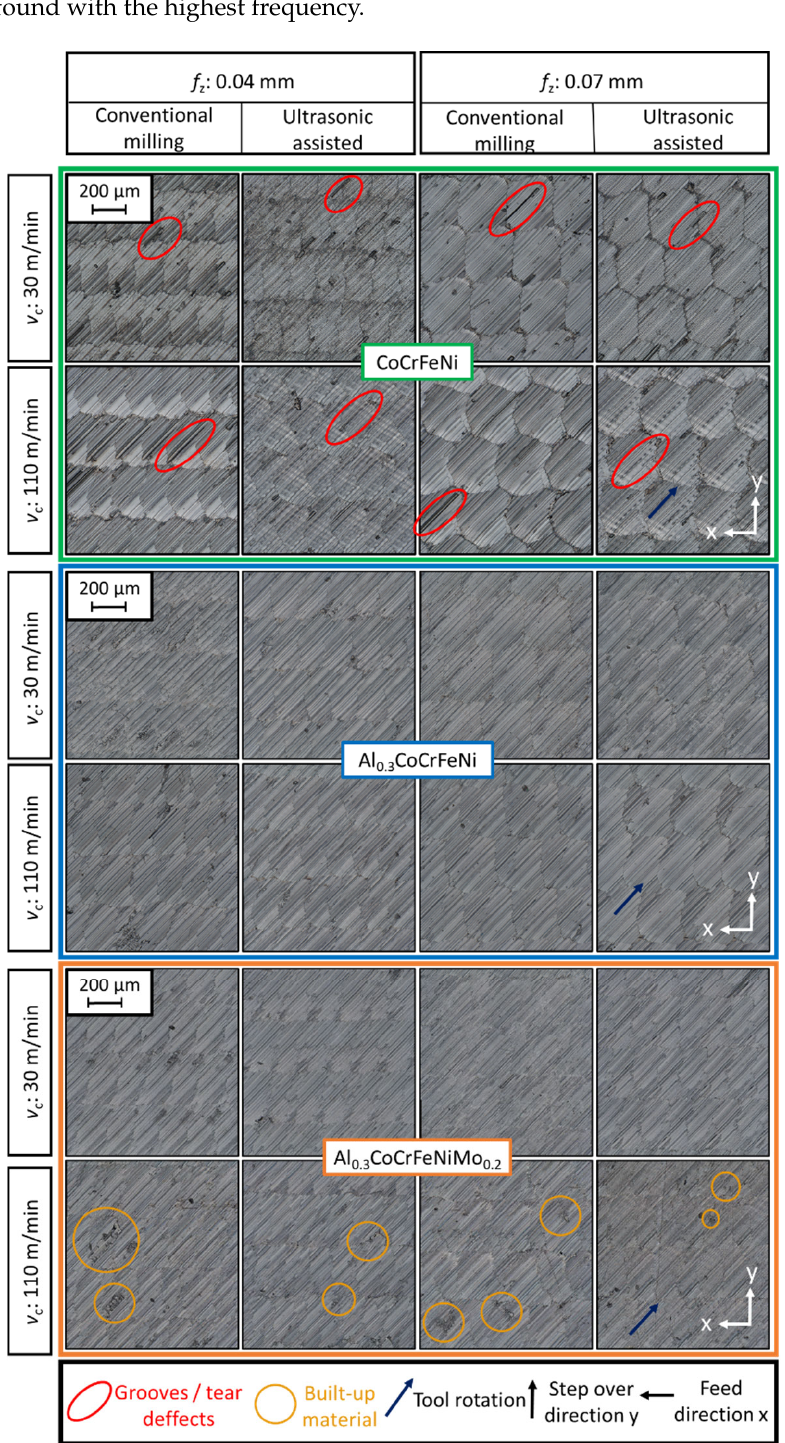
Figure 7. Light-optical-microscopy images of the milled surfaces of the CoCrFeNi (green box), Al 0 . 3 CoCrFeNi (blue box), and Al 0 . 3 CoCrFeNiMo 0 . 2 (orange box), with surface defects marked. Comparison between low (30 m/min) and high (110 m/min) cu tt ing speed and low (0.04 mm) and high (0.07 m/min) feed per cu tt ing edge, with and without ultrasonic assistance.